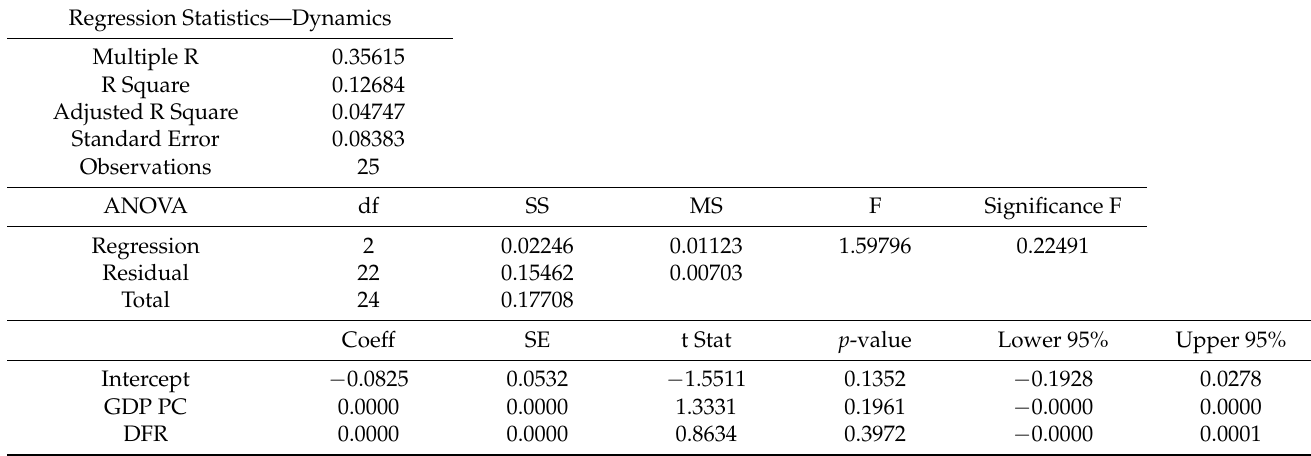
Table 4. Multiple linear regression model analysis in respect of DRs dynamics.